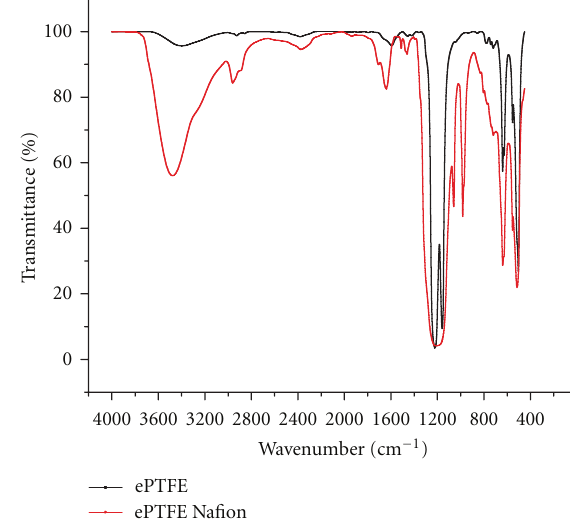
Figure 2: IR curves for the substrate and the composite